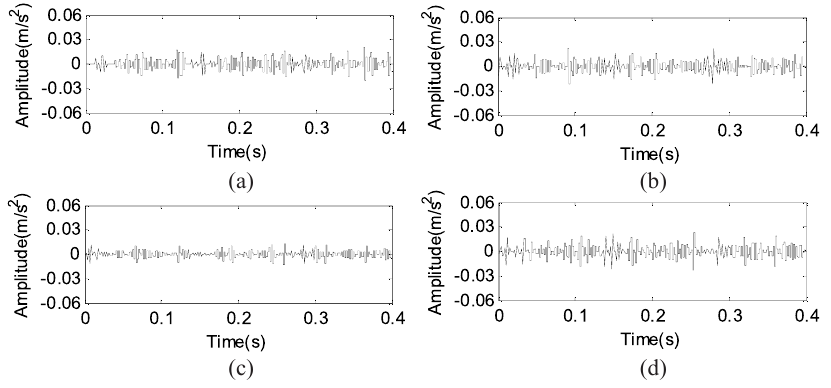
Fig. 9. The reconstructed vibration signal of (3,1) in three-level decomposition of WPA under four conditions, (a) F 1 , (b) F 2 , (c) F 3 and (d) F 4 . different, which is not enough to classify the fault conditions of the gears in gearbox. As described in Table 1